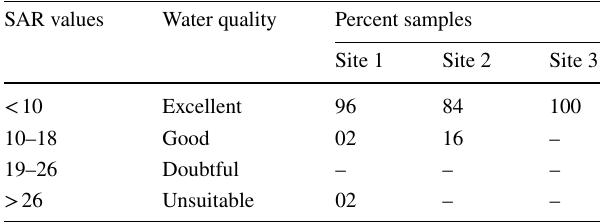
Table 13 Classification of irrigation water on SAR